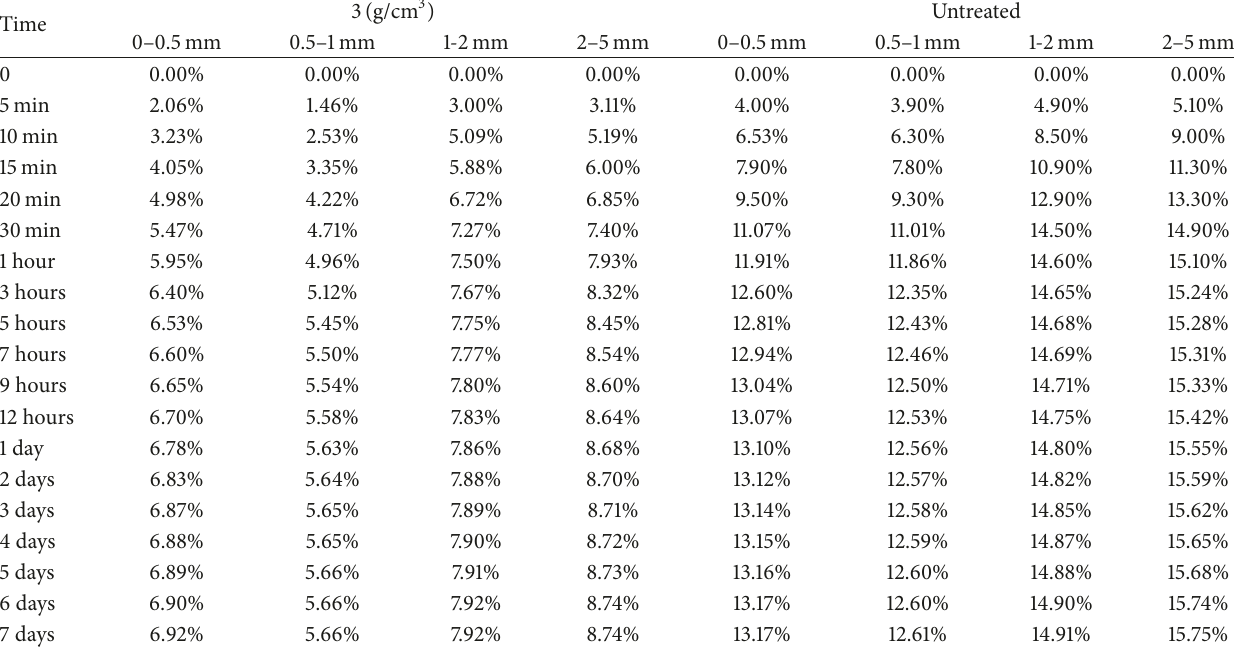
Table 2: The linear swelling ratio of specimens with different aggregate sizes.